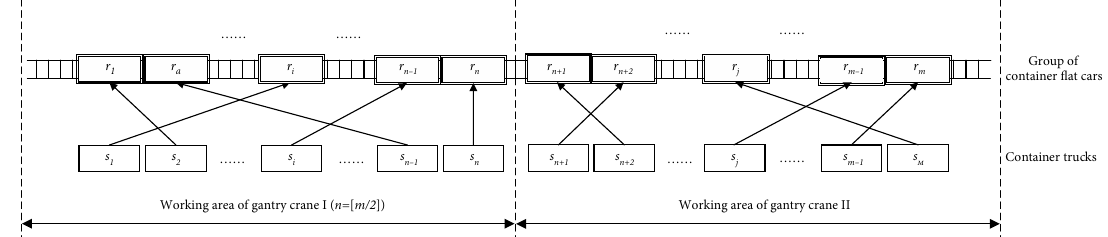
Figure 1: The position map of container trucks and flat cars on the loading and unloading line.